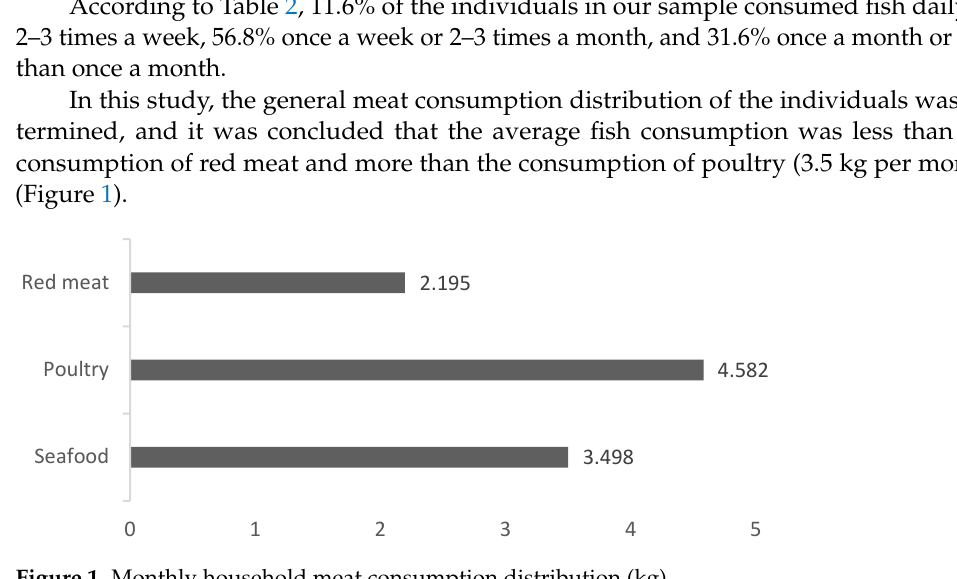
Figure 1. Monthly household meat consumption distribution (kg).